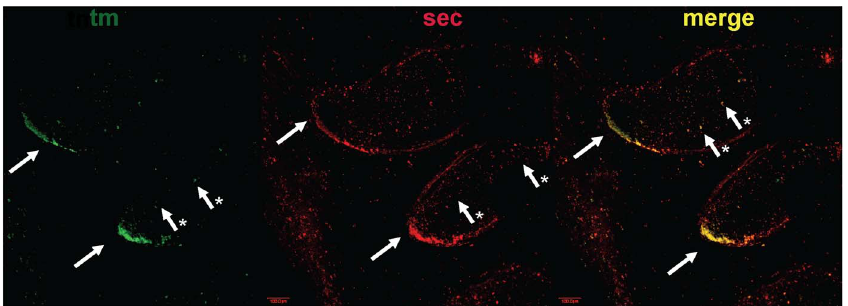
Figure 3. Localization of fuhc sec and fuhc tm using whole mount double-labeled in situ hybridization. Probes specific for fuhc sec and fuhc tm were hybridized to whole mount preparations as described in the methods, and results are shown for fuhc tm (green) and fuhc sec (red) as well as the merged image. Both genes are expressed in the epithelium of the ampullae as well as a subset of blood cells. Note that while detection of fuhc sec is repeatable, detection of fuhc tm was variable, in that we saw either this staining pattern, or no detection of fuhc tm mRNA at all. This is most likely due to low levels of expression (Table 1).